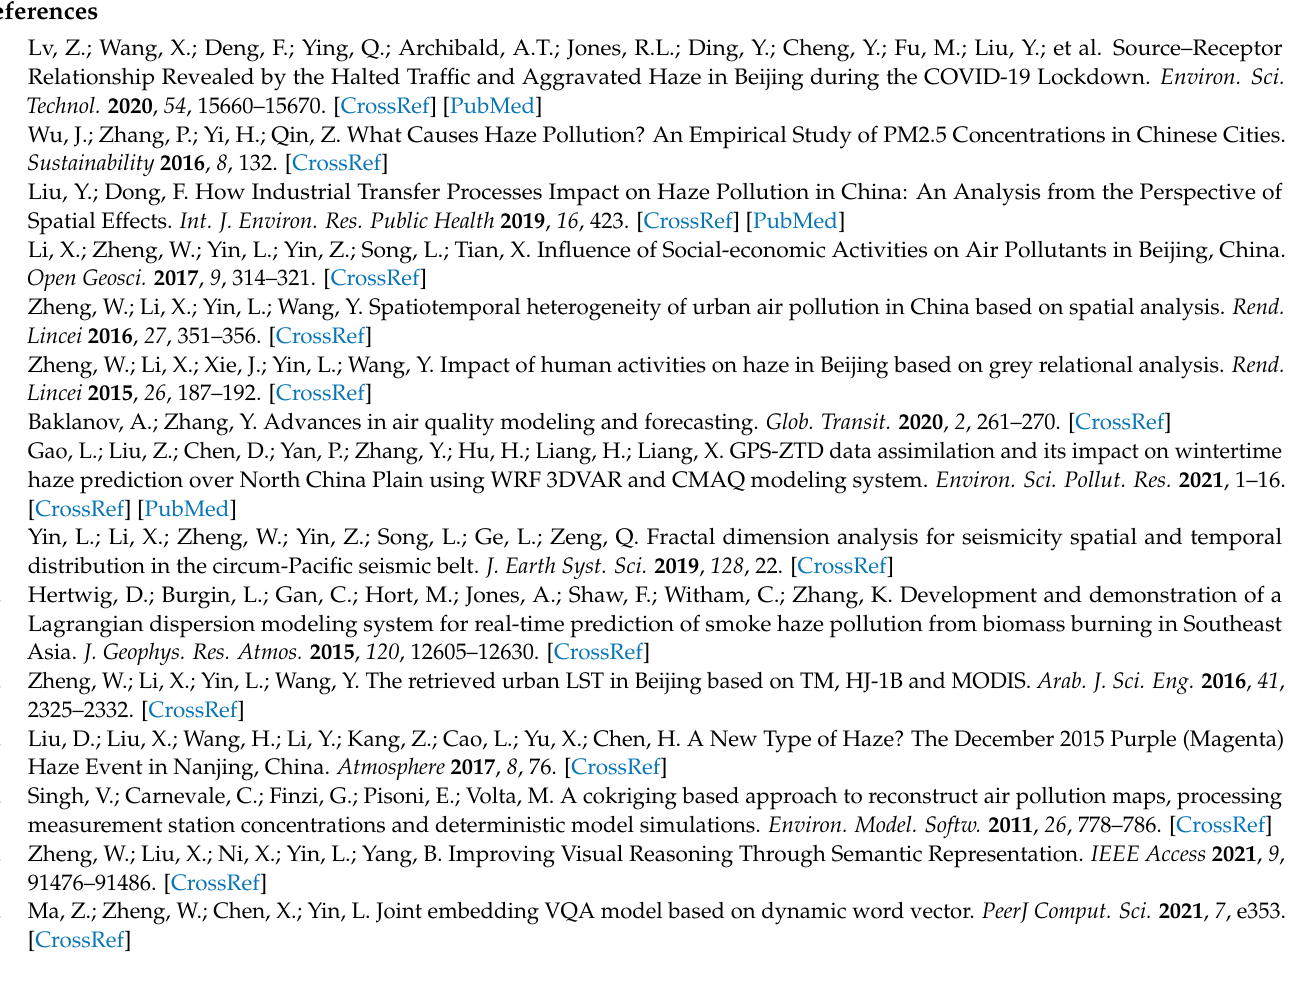
(3) According to the PM10 prediction results, as with the PM2.5 prediction results, pre- diction accuracy is related to the number of hidden layers. The larger the number of hidden layers is, the higher the prediction accuracy will be. The prediction results of a deep recurrent neural network with eight hidden layers are the best. (4) To ensure prediction accuracy, the most simplified neural network is selected to predict PM2.5/PM10. Good results can be achieved when PM2.5/PM10 is predicted using a deep recurrent neural network with seven hidden